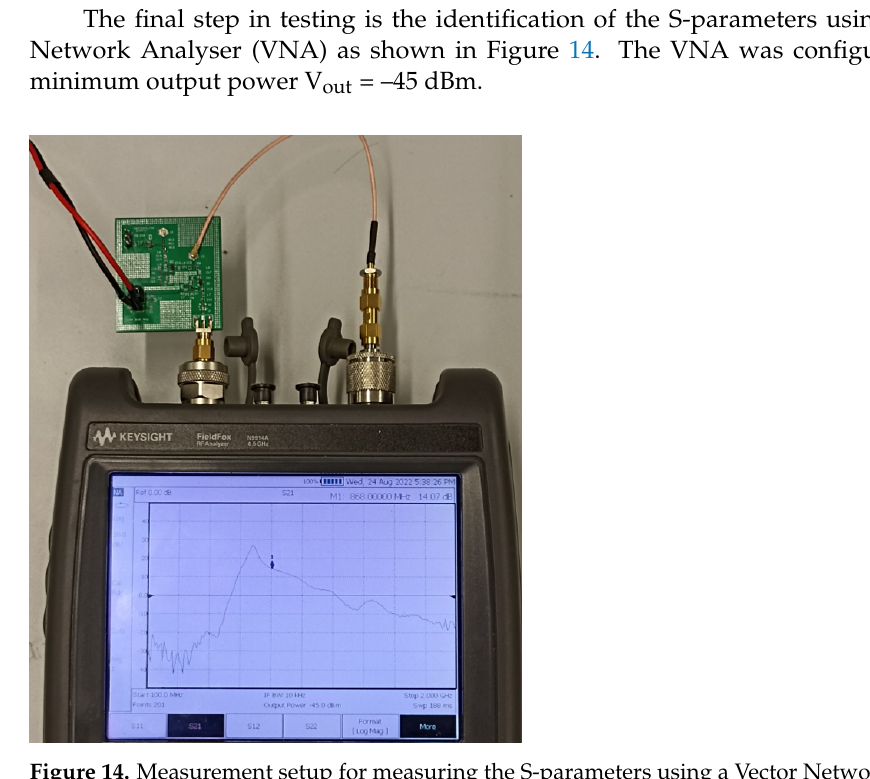
Figure 14. Measurement setup for measuring the S-parameters using a Vector Network